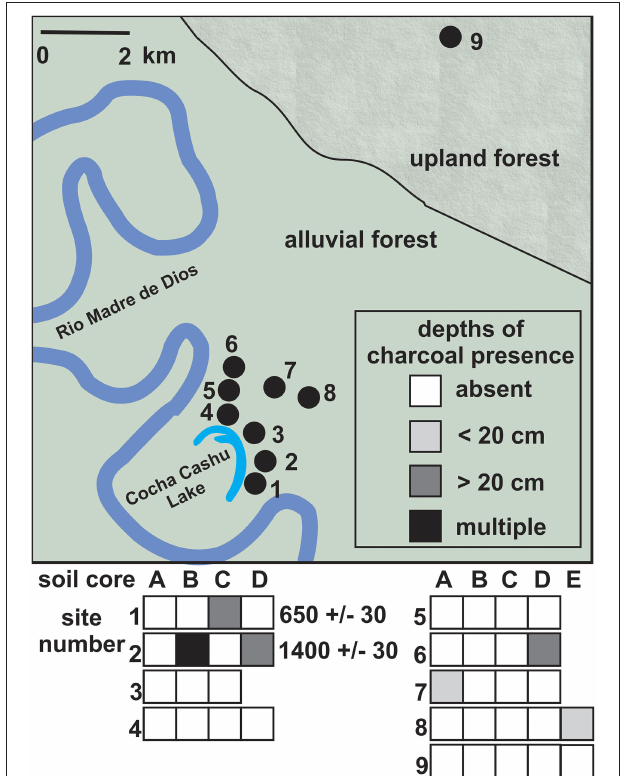
FIGURE 2 | Charcoal sampling locations (top) and charcoal frequency from 37 cores collected at 9 sites across the Cocha Cashu forest (bottom). Sites 1–8 were located on mature alluvial floodplain forest, and site 9 was located on closed canopy terra firme forest. The only two charcoal fragments recovered that were large enough for 14 C AMS dating were from Sites 1 and 2, near the oxbow lake. Colored boxes correspond with the depths at which the charcoal fragments were found (see legend).